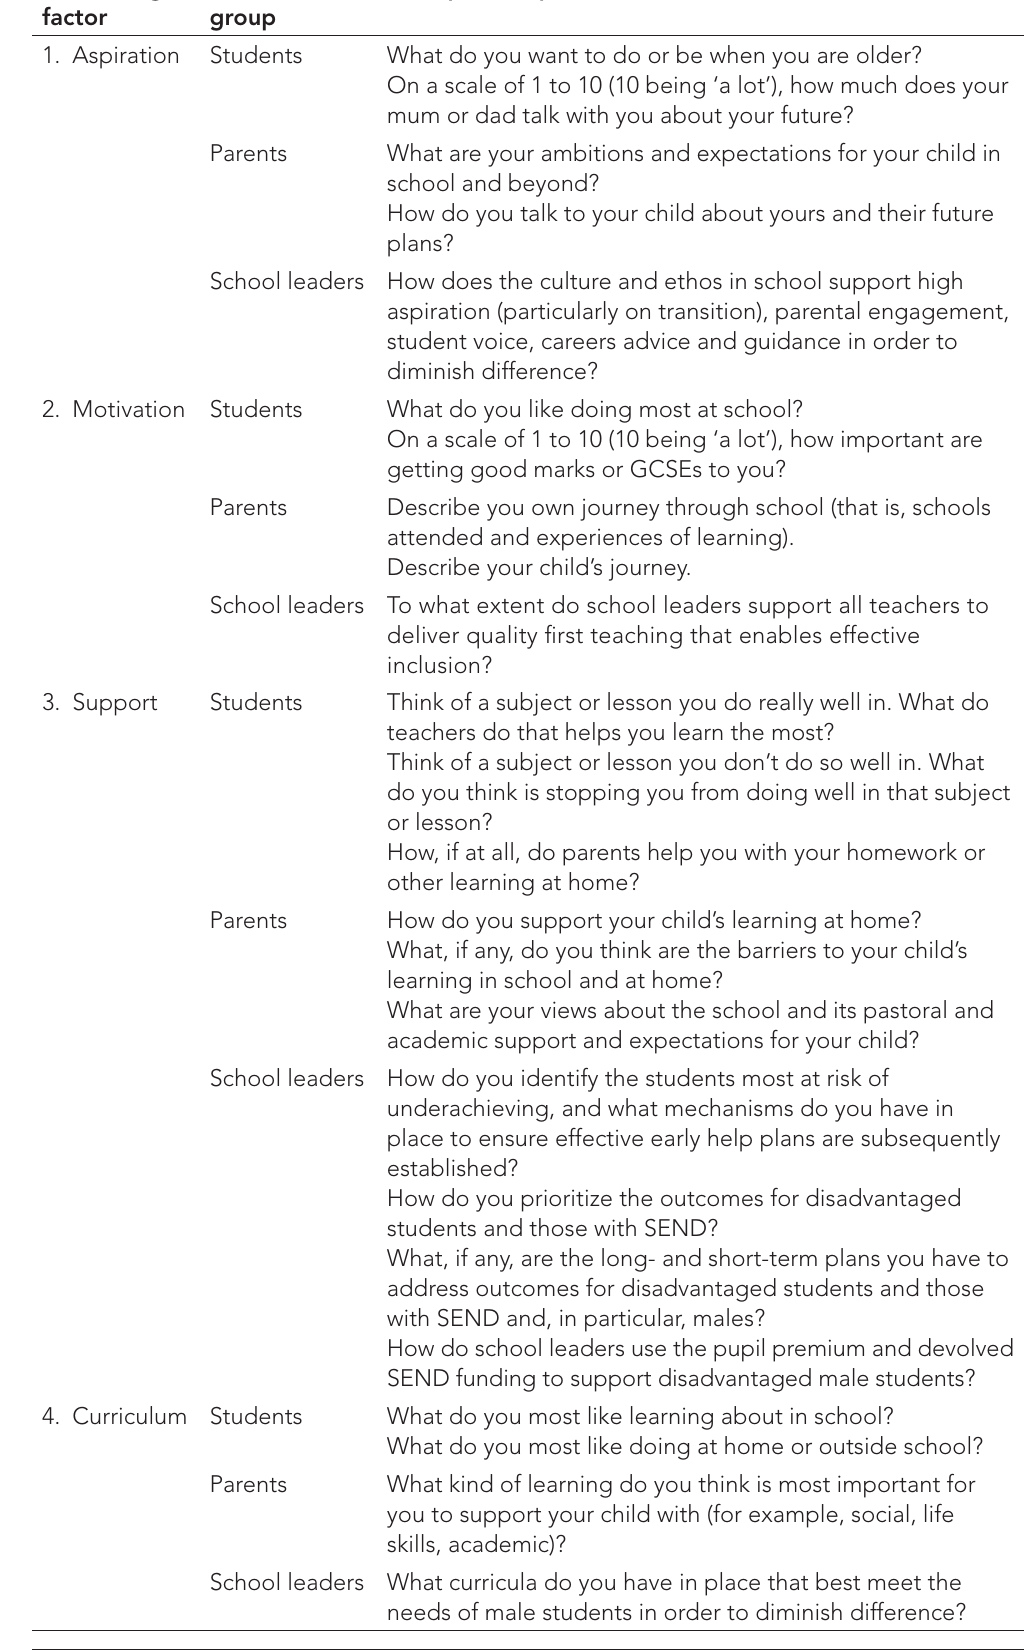
Table 1: Focus group questions Influencing